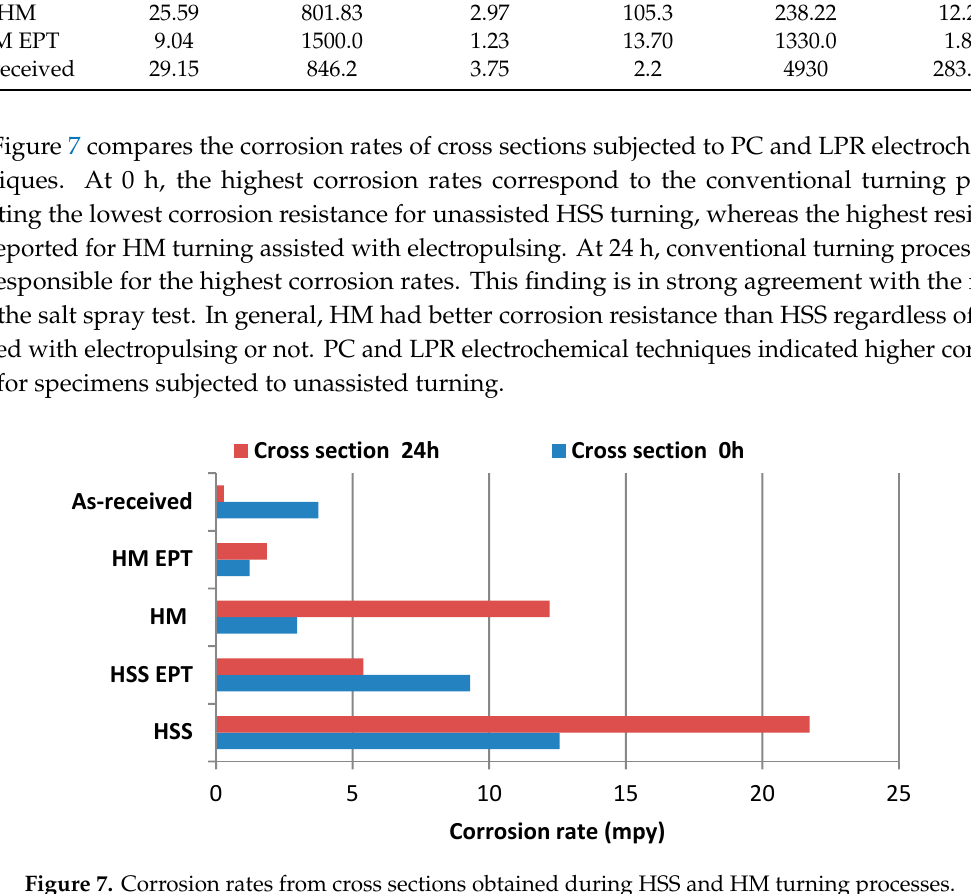
Figure 7. Corrosion rates from cross sections obtained during HSS and HM turning processes.